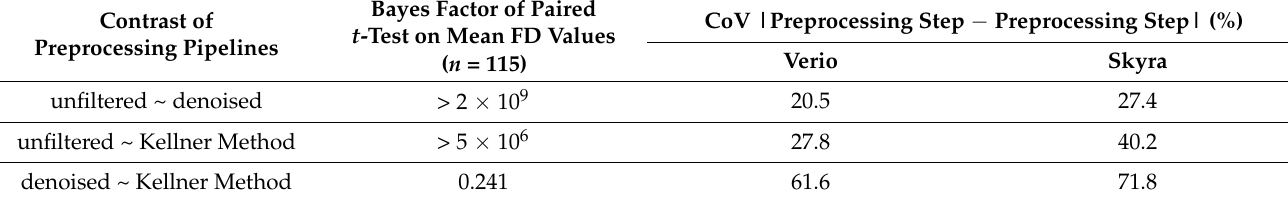
Table 4. Absolute head motion values per preprocessing pipeline and per scanner. Head motion estimated from the diffusion weighted images is significantly lower in Skyra than Verio independent of preprocessing pipeline (all BF >> 3). The CoV of the scanner difference in head motion is of comparable size between preprocessing pipelines. Table 3. Results of statistical analysis of head motion values (FD) with and without preprocessing with paired Bayesian t -tests. Denoising and unringing reduce head motion artefacts significantly. The CoVs of the preprocessing pipeline dif- ferences in head motion differ largely. Preprocessing